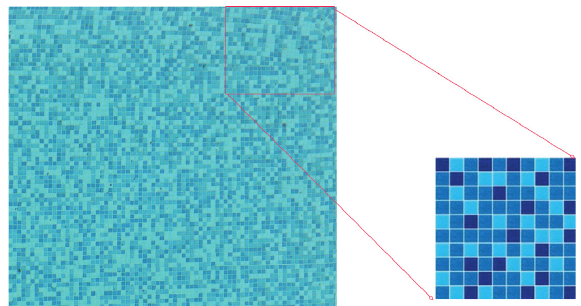
Figure 5: Random attenuation mask pattern.